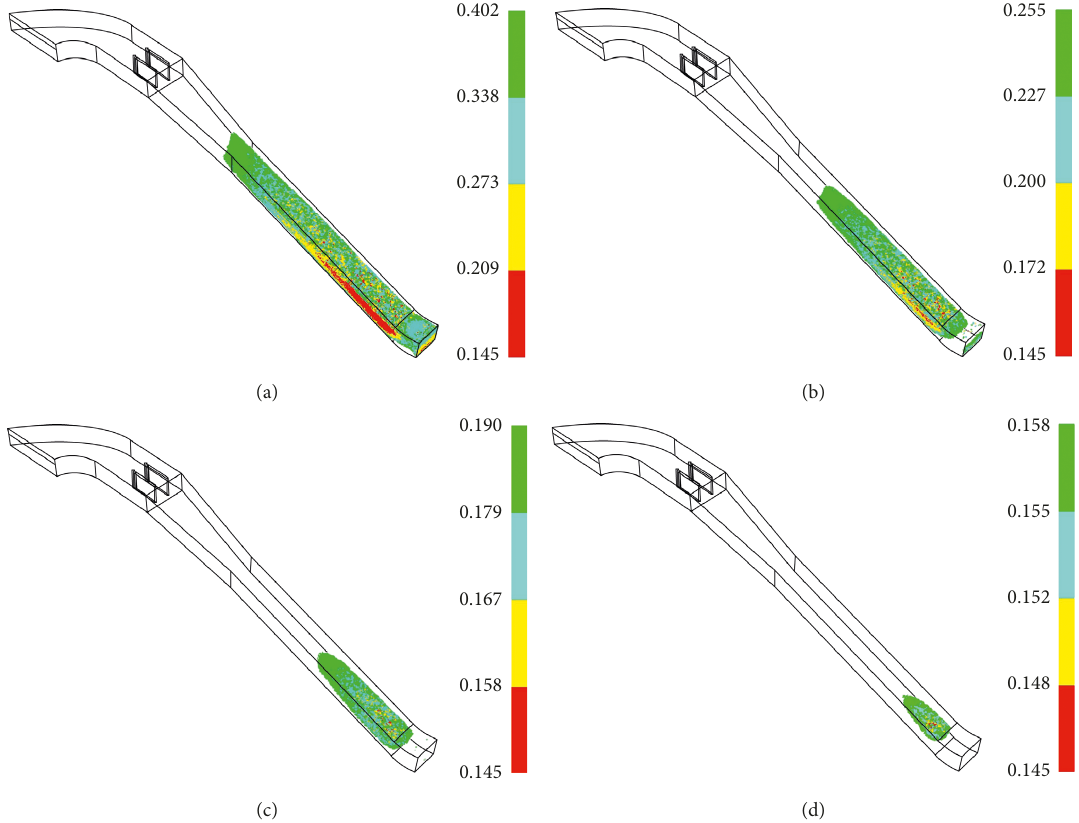
Figure 16: Three-dimensional prediction of the potential cavitation zone.